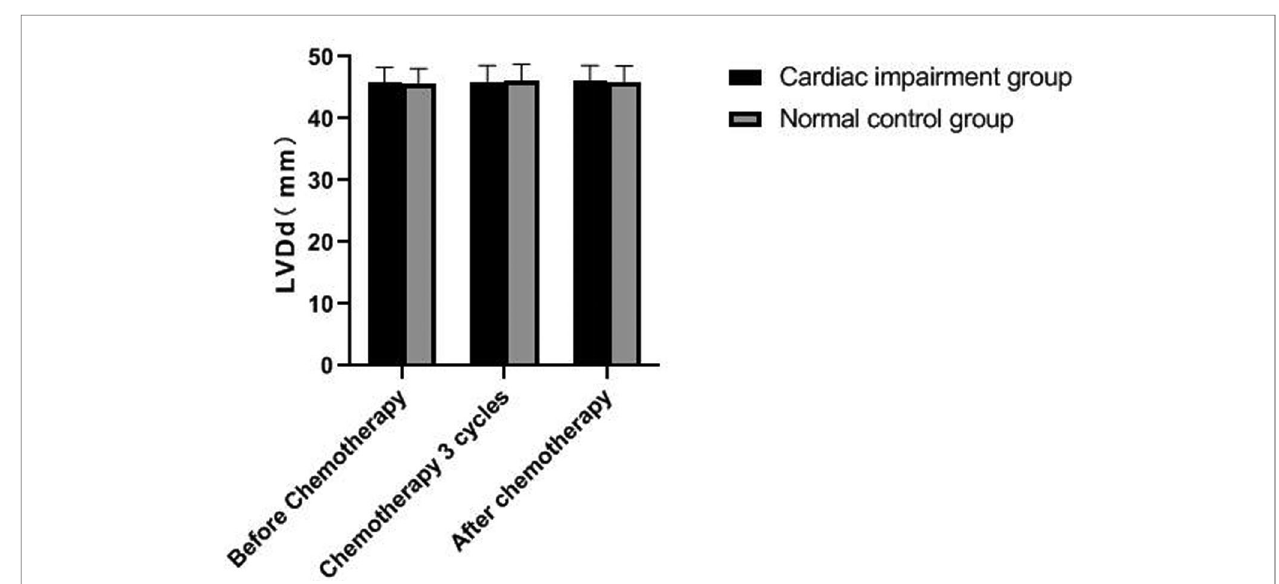
FIGURE 3 | Comparison of LVDd values between the two groups at different time